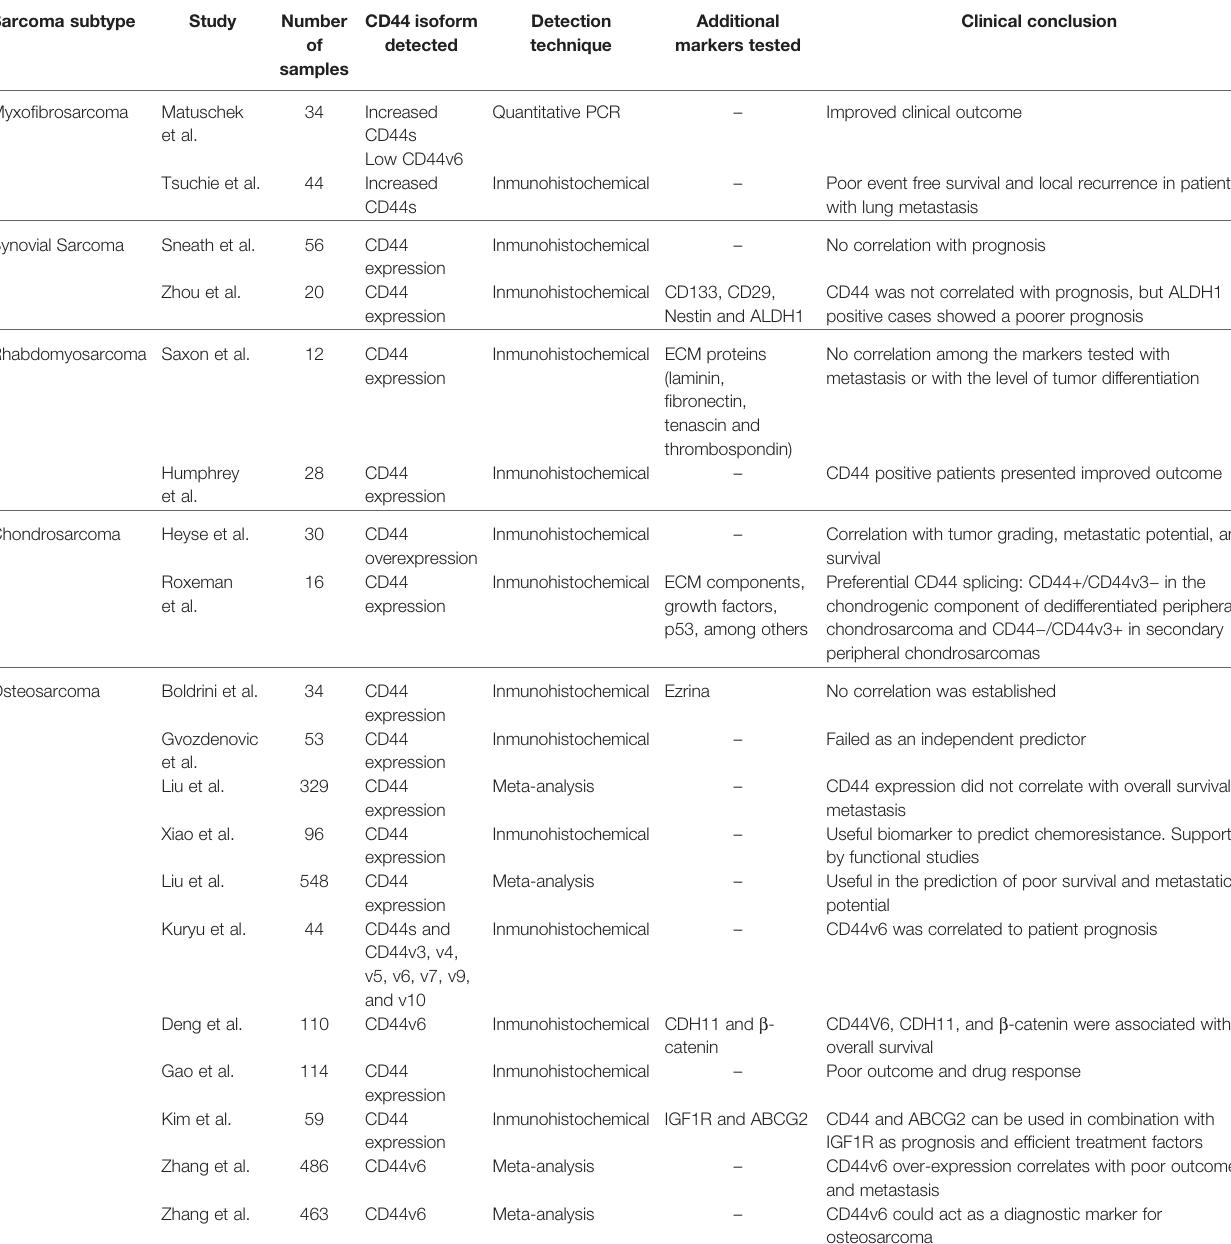
TABLE 1 | Summary of sarcoma subtype studies analyzing CD44 expression alone or in combination with other biomarkers in patient